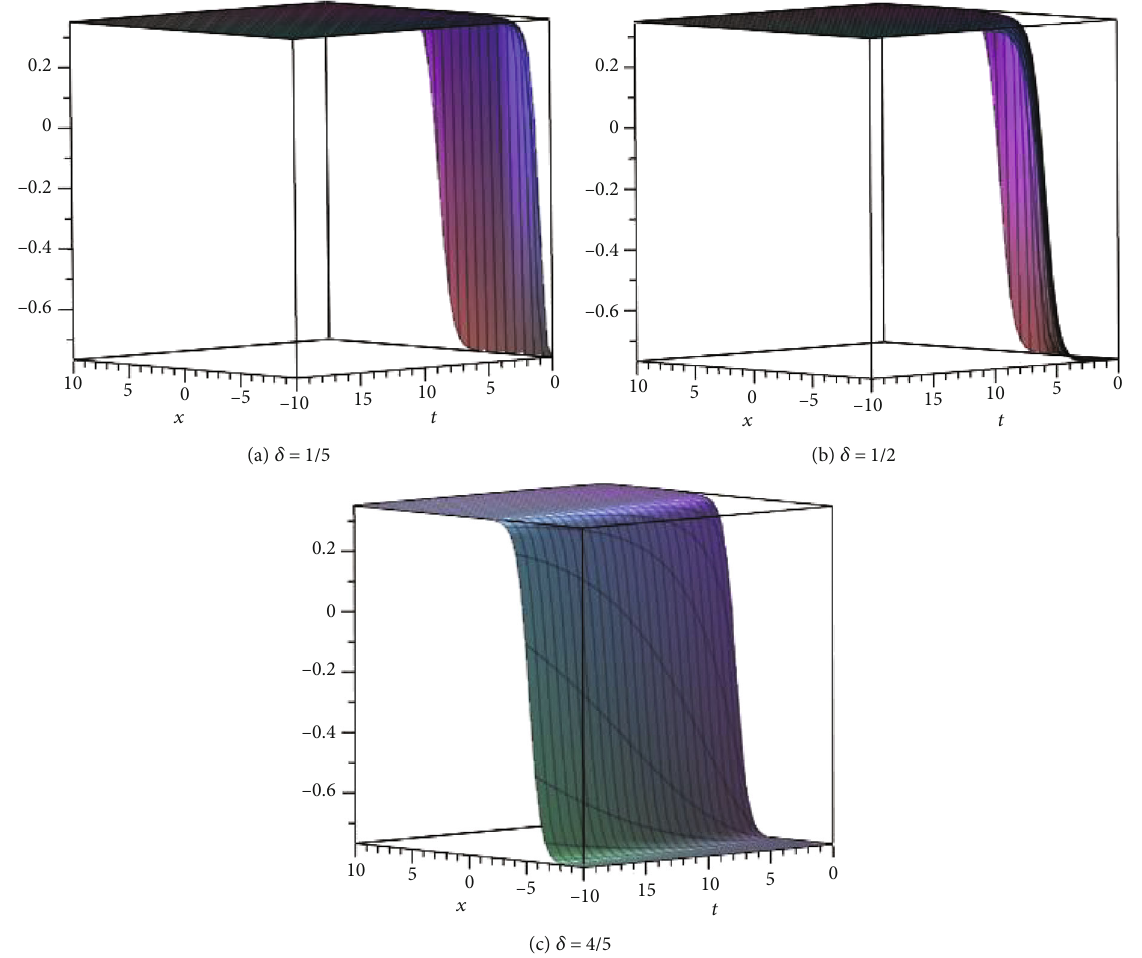
, x Þ in Equation (37) for di ff erential values of the fractional parameter δ Figure 5: The positive real part of u 1 1 ð t